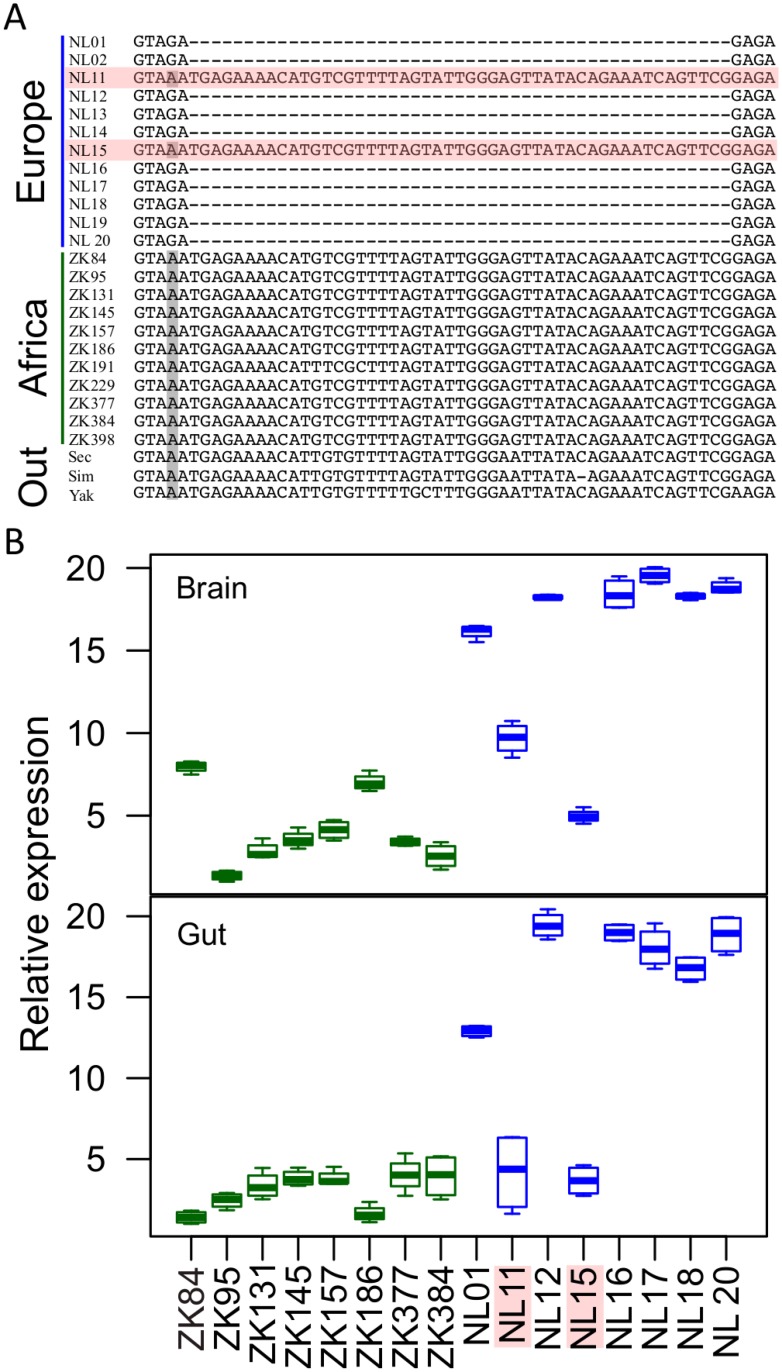
Association between an indel polymorphism in the MtnA 3' UTR and gene expression variation.(A) An indel (and a linked SNP marked in gray) in the MtnA 3' UTR are the only polymorphisms within the 6-kb MtnA region that show a large difference in frequency between an African and a European population of D. melanogaster. A comparison with three outgroup species, D. sechellia (Sec), D. simulans (Sim) and D. yakuba (Yak), indicated that the deletion is the derived variant. (B) MtnA expression in the brain and the gut of eight European (NL) lines, shown in blue, and eight African (ZK) lines, shown in green. The two European lines lacking the deletion, NL11 and NL15, show lower MtnA expression than those with the deletion.